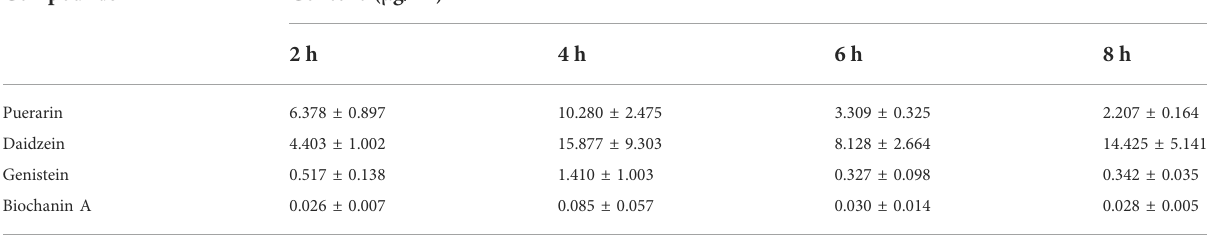
TABLE 2 Contents of major urine metabolites after oral administration of Gegen water extract in SHR detected by LC-MS/MS (Mean ± SEM; n = 8). Compounds